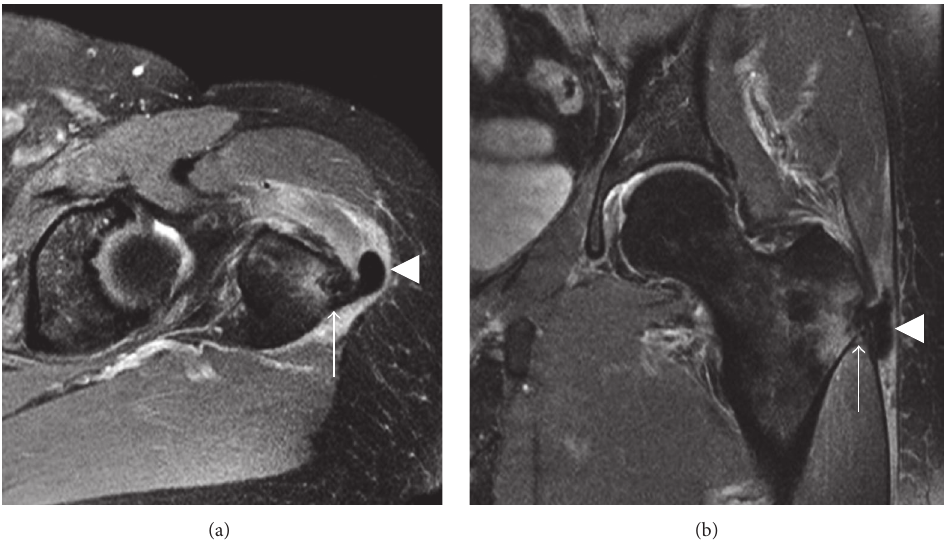
Figure 6: Calcific bursitis with osseous erosion. (a) and (b) Axial and coronal MRI images show a large conglomeration of soft tissue calcification within the greater trochanter bursa with surrounding soft tissue edema (arrowheads). The calcifications about the greater trochanter and erode the cortex with reactive edema of the adjacent bone marrow